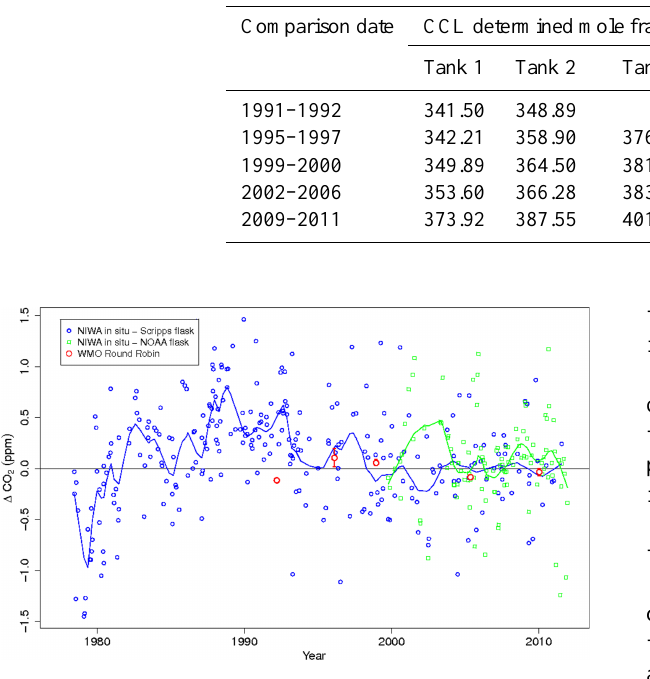
Fig. 4. Intercomparison results shown as the difference between in situ Baring Head measurements and Scripps flasks, NOAA flask pairs, and WMO round-robin cylinders, respectively. Comparisons have been filtered for a maximum time difference of 30min, a max- imum standard deviation on in situ CO 2 over a centred 2-h period of 0.75ppm, and to exclude outliers > 3 σ . Lines represent Loess filters to each dataset using a 2-yr smoothing